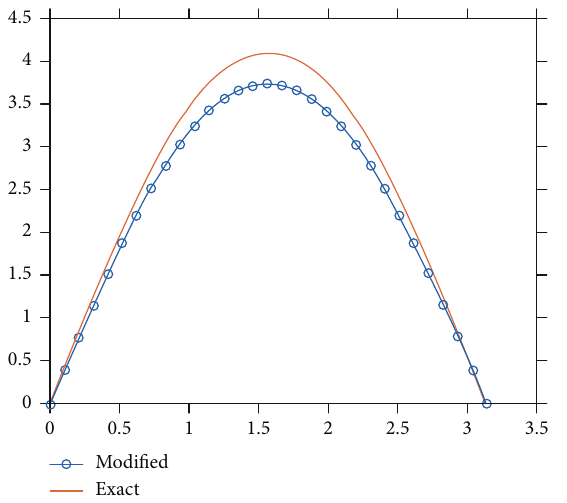
Figure 8: The disparity between the exact solution of the system of equations (2) – (5) and the regularized solution of the system of equations (12) – (15) for p = 2 and k = 1